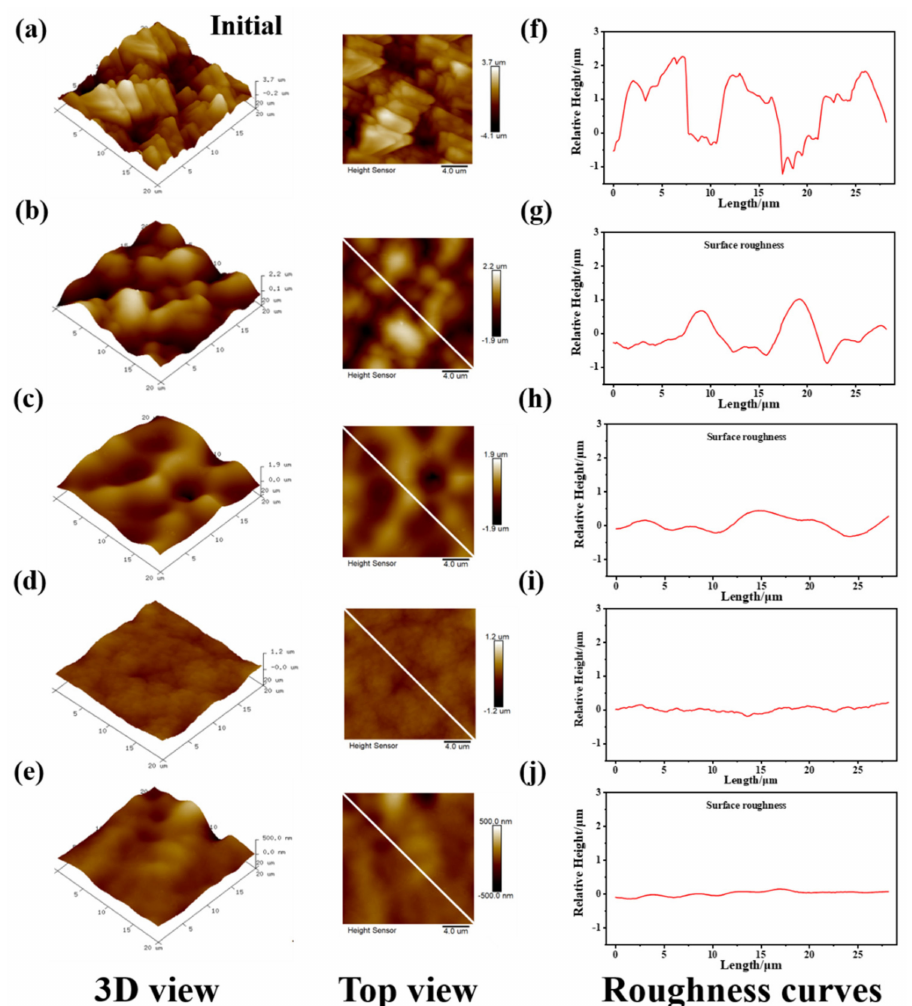
Figure 3. AFM images and surface roughness curves of electrolytic copper foils with different roughness: ( a , f ) CF-3.6, ( b , g ) CF-2.8, ( c , h ) CF-2.2, ( d , i ) CF-1.5, ( e , j )